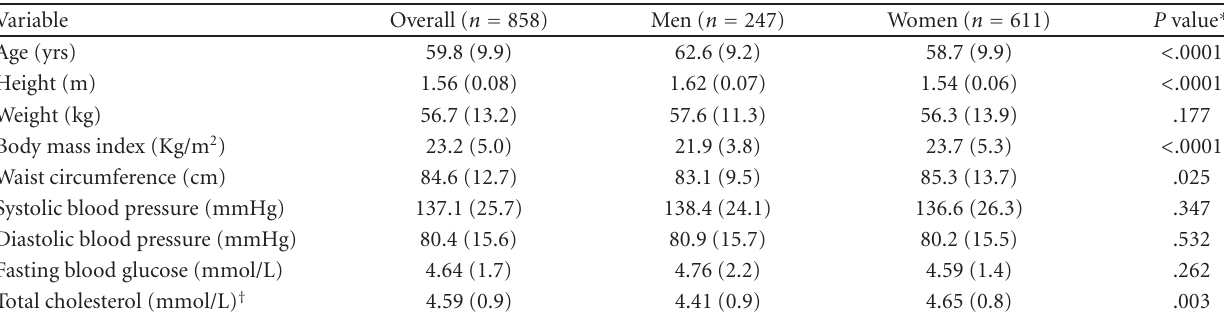
Table 1: Characteristics of the population.